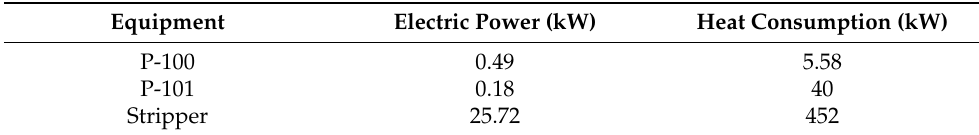
Table 10. Equipment energy consumption biogas upgrading process- chemical scrubbing.